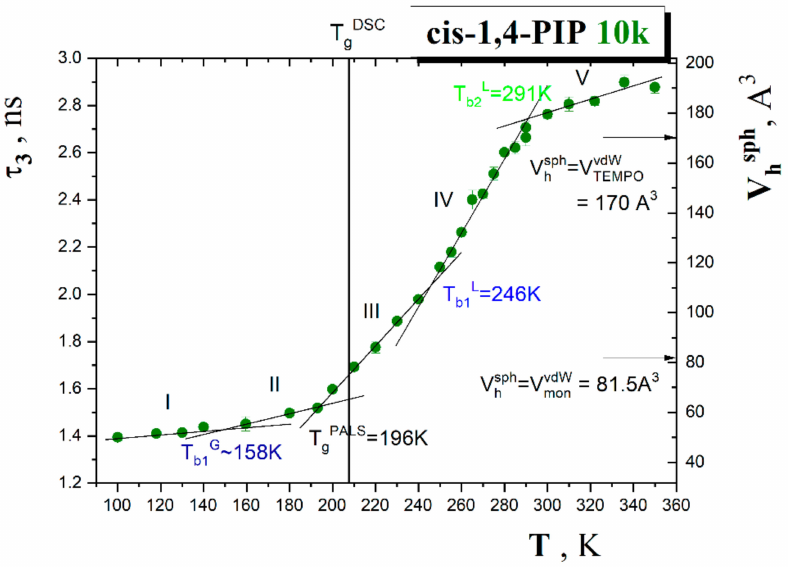
Figure 5. The o -Ps lifetime, τ 3 , and equivalent spherical-like free volume, V hsph , as a function of tem- perature in the pure cis -1,4-PIP10k medium with the characteristic PALS temperatures: T b1 G~ 158 K, T gPALS = 194 K, T b1 L = 246 K, T b2 L = 291 K determined as an intersction poin points of two linear fits. Error bars are included. The equivalent spherical free volumes V h sph compared to the vdW volume of monomer V monvdW and vdW volume of TEMPO V TEMPO vdW are marked by the corresponding arrows. The glass-to-liquid temperature T g DSC = 208 K is depicted by the vertical